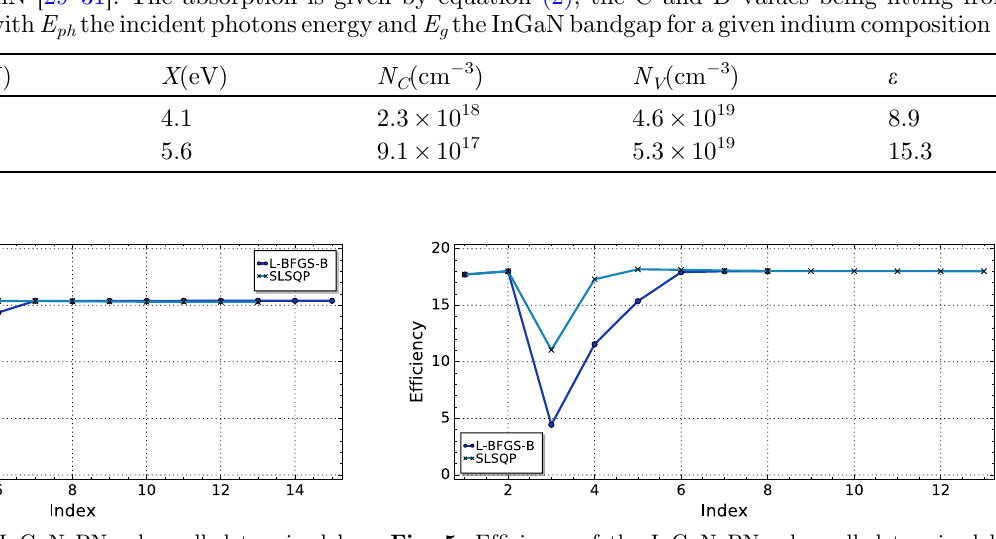
and in the valence C